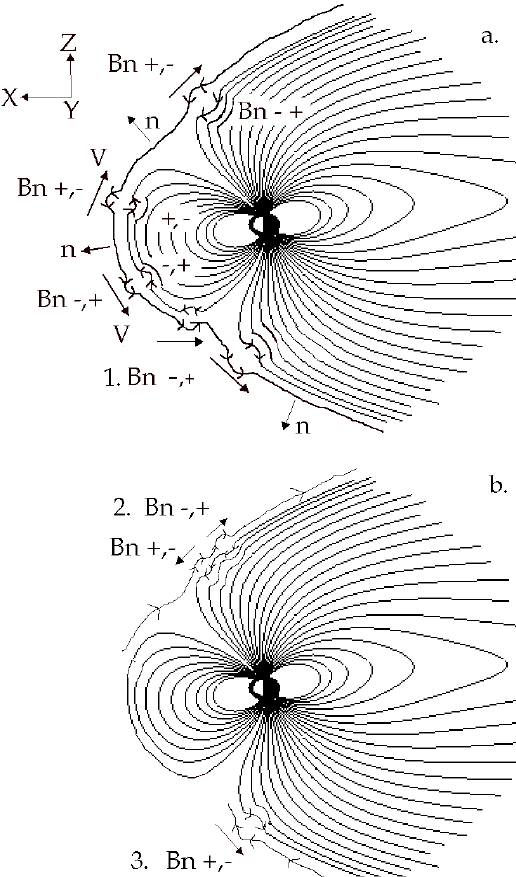
Fig. 1. (a) The bipolar signatures (Bn) normal to the nominal mag- netopause predicted for events generated by merging on the sub- solar magnetopause during intervals of southward IMF orientation. Direct (+,–) signatures are expected in the magnetosheath north of the merging site, in the dayside equatorial magnetosphere north of the merging site, and in the southern lobe. Reverse (–,+) signatures are expected in the magnetosheath south of the merging site, in the dayside equatorial magnetosphere south of the merging site, and in the northern lobe. The bipolar signatures generated by events in the cusp lie in the z-direction, rather than the direction normal to the nominal magnetopause (position 1). (b) The bipolar signatures normal to the nominal magnetopause predicted for events gener- ated by merging on the high latitude magnetopause during periods of northward IMF orientation. Sunward moving events generate di- rect signatures on the northern magnetopause, reverse signatures on the southern magnetopause. Antisunward-moving events generate reverse events on the northern magnetopause (position 2), direct events on the southern magnetopause (position